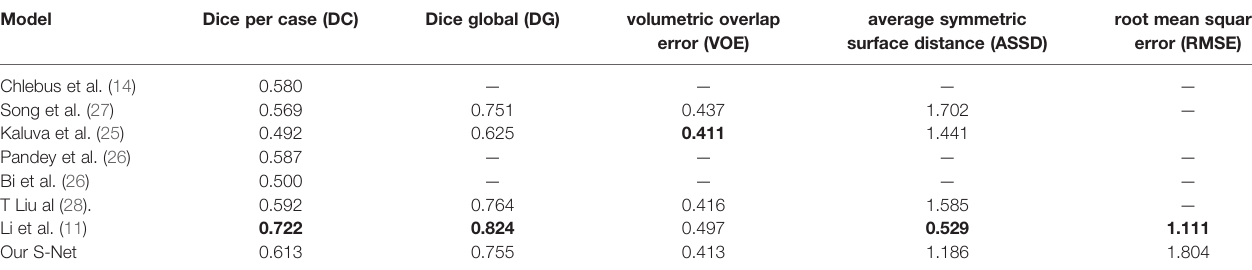
TABLE 2 | Liver tumor segmentation results compared with other methods on the LiTS test dataset.